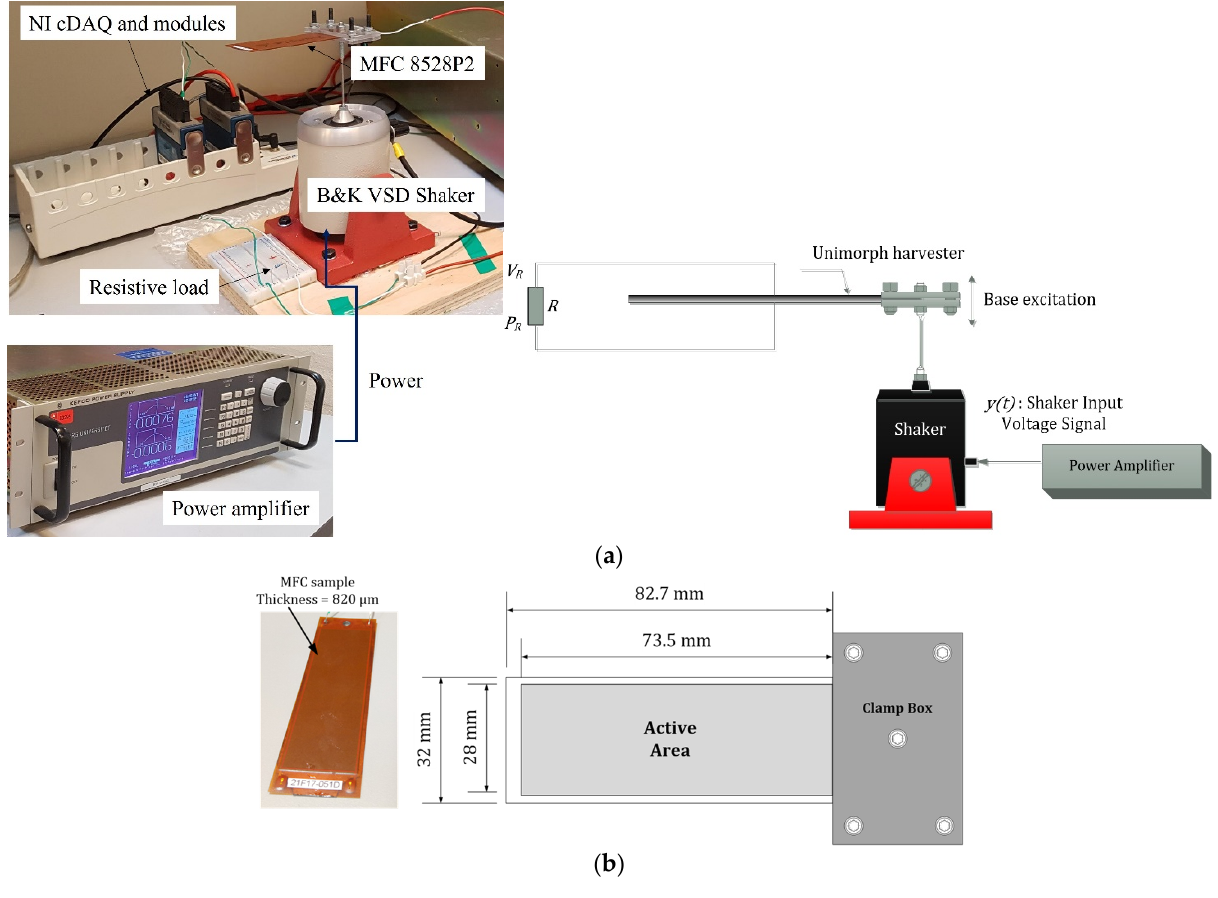
Figure 3. ( a ) Test rig and ( b ) MFC piezoelectric sample dimensions.